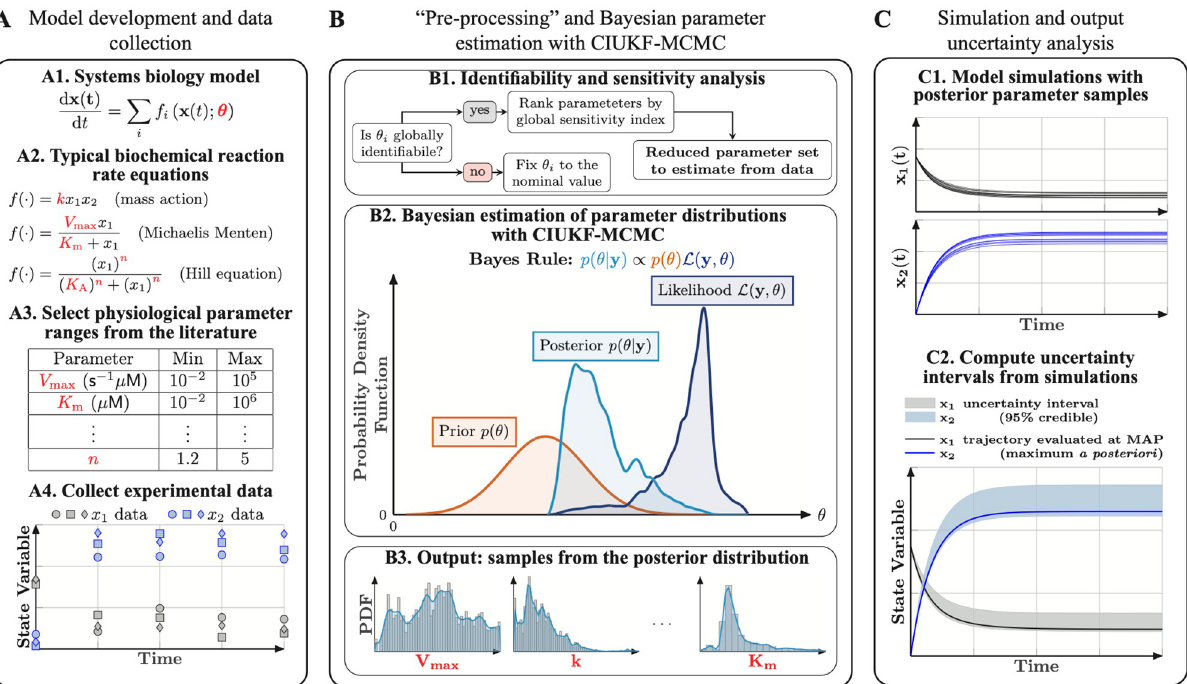
Fig 1. A comprehensive Bayesian parameter estimation and uncertainty quantification framework for dynamical models in systems biology. ( A ) Model development in systems biology begins with model construction and data collection. Dynamical models in systems biology typically involve a system of ODEs that capture the dynamics of the concentrations of different chemical species in the system (A1). The reaction rates associated with these concentration changes are usually mass action, Michaelis Menten kinetics, or cooperative kinetics represented by the Hill equation (A2). The free parameters in these models include kinetic rate constants, e.g. k , V max , equilibrium constants, e.g. K , K , and Hill coefficients, e.g. n . These parameters m A are first constrained by best guess values based on physiological ranges and typical values of model parameters from the literature (A3). Finally, the model needs experimental data for validation; this data can either be from published work or new experiments. ( B ) Parameter preprocessing and Bayesian parameter estimation with the CIUKF-MCMC algorithm. First structural identifiability and global sensitivity analyses on the entire parameter set reduce the set of free parameters that can be estimated (B1). Next, we perform Bayesian parameter estimation for this reduced set of parameters to learn their posterior distributions. The posterior distribution is the parameter distribution conditioned on the data (B2). Bayes’ rule relates the posterior distribution to the product of the prior distribution and the likelihood function. The prior distribution encodes known information about the parameters and the likelihood function (which requires simulating the model) measures the misfit between predictions and the data. A state- constrained Unscented Kalman filter approximates the likelihood function to account for uncertainty in the model equations. Although Bayes’ rule provides a means to evaluate the posterior distribution at specific points in the parameter space, we use Markov chain Monte Carlo (MCMC) sampling (B3) to characterize the entire distribution. ( C ) The posterior distributions enable uncertainty analysis of model outputs through ensemble simulation. We perform simulations using the posterior parameter samples to propagate parameter uncertainty through the model (C1). Statistical analysis of the ensemble enables us to compute uncertainty intervals and study various system behaviors, for example, the statistics of the steady state values